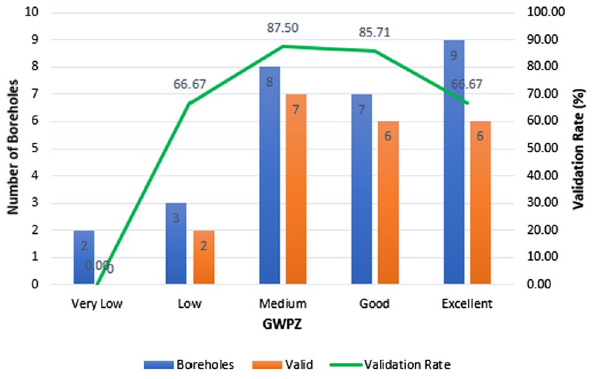
Fig. 5 Validation results in Chott-El-Gharbi